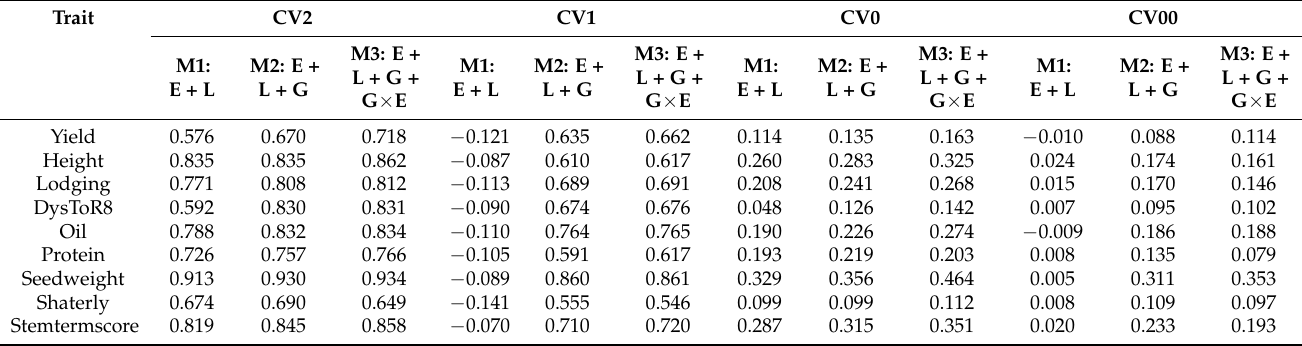
Table 2. Average mean (10 replicates) correlation between predicted and observed values for four cross-validation scenarios, three models (M1: E + L, M2: E + L + G, and M3: E + L + G + G × E) and 9 traits from a sample of the USDA Soybean collection comprised of 324 genotypes observed in 6 environments (not all genotypes in all environments).